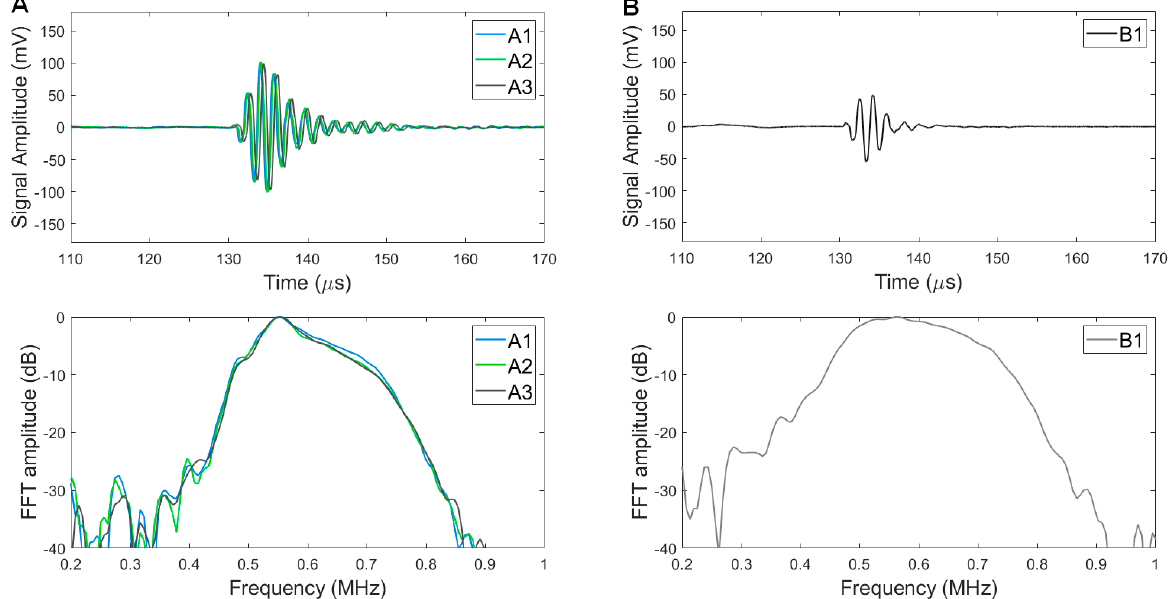
Figure 5. Pulse − echo responses of type A ( A ) and type B ( B ) transducers: waveforms ( upper ) and FFT results ( lower ).